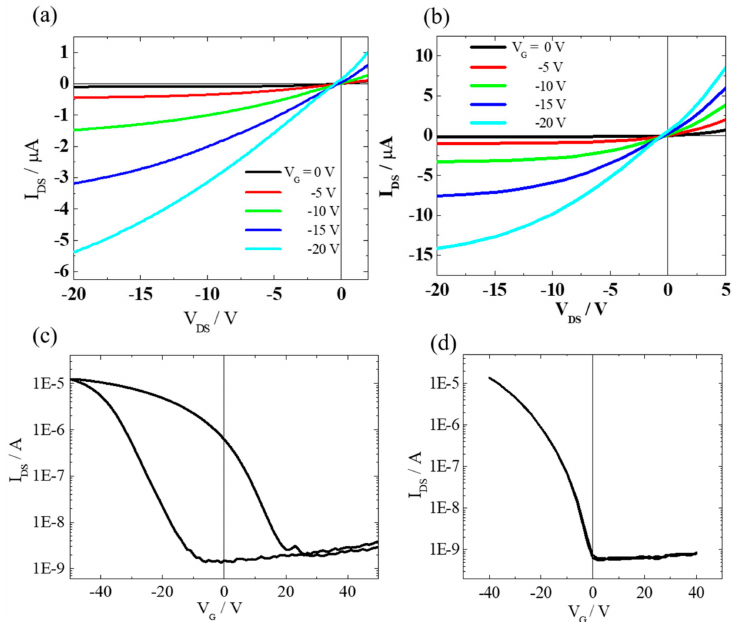
Figure 5. The electrical performance of organic TFT (OTFT) memory device with polypeptide gate dielectric. The output characteristic of drain-source current versus drain-source voltage (I DS –V DS ) plot of ( a )PMLG ( b ) PBLG based device. The transfer characteristic of drain-source current versus gate voltage (I DS vs. V G ) plot of ( c ) PMLG ( d ) PBLG based device. ( c ) PMLG ( d ) PBLG based